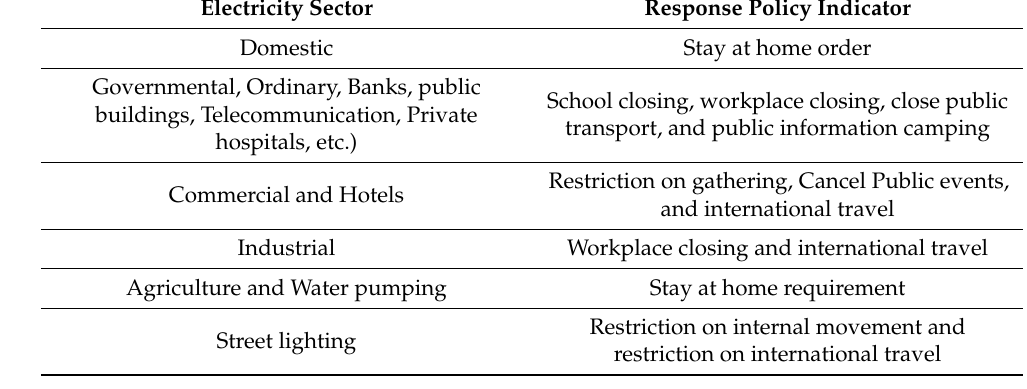
Table 1. Correlation between electricity consumption sectors and government response indicators.